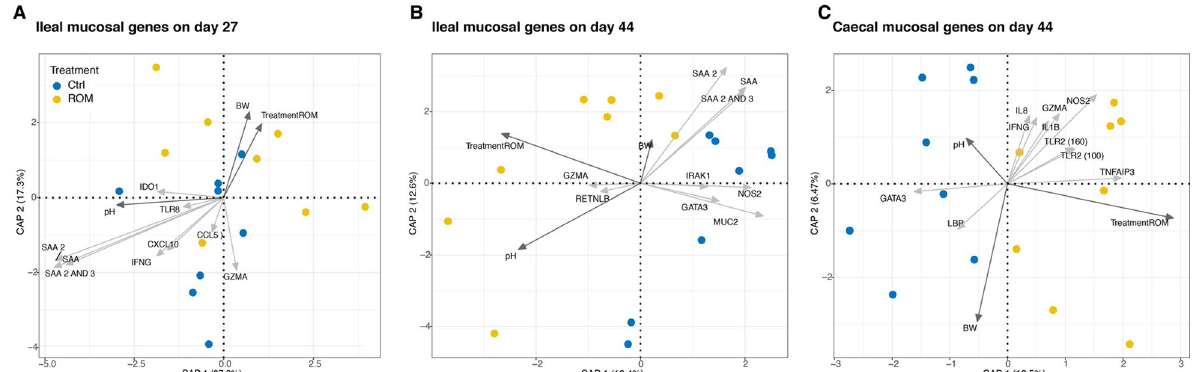
Fig. 5 Redundancy analysis (RDA) triplots show the association between the variation of gene expression and environmental variables, focusing on samples from ileum on day 27 ( A ) and day 44 ( B ), as well as caecum ( C ) on day 44. Blue and yellow colours represent control (Ctrl) and treated (ROM) groups, respectively. Dark grey arrows indicate environmental variables and light grey arrows show genes for which variation in expression levels is best explained in the model. The percentages at the axes indicate the variation explained by the first two canonical axes